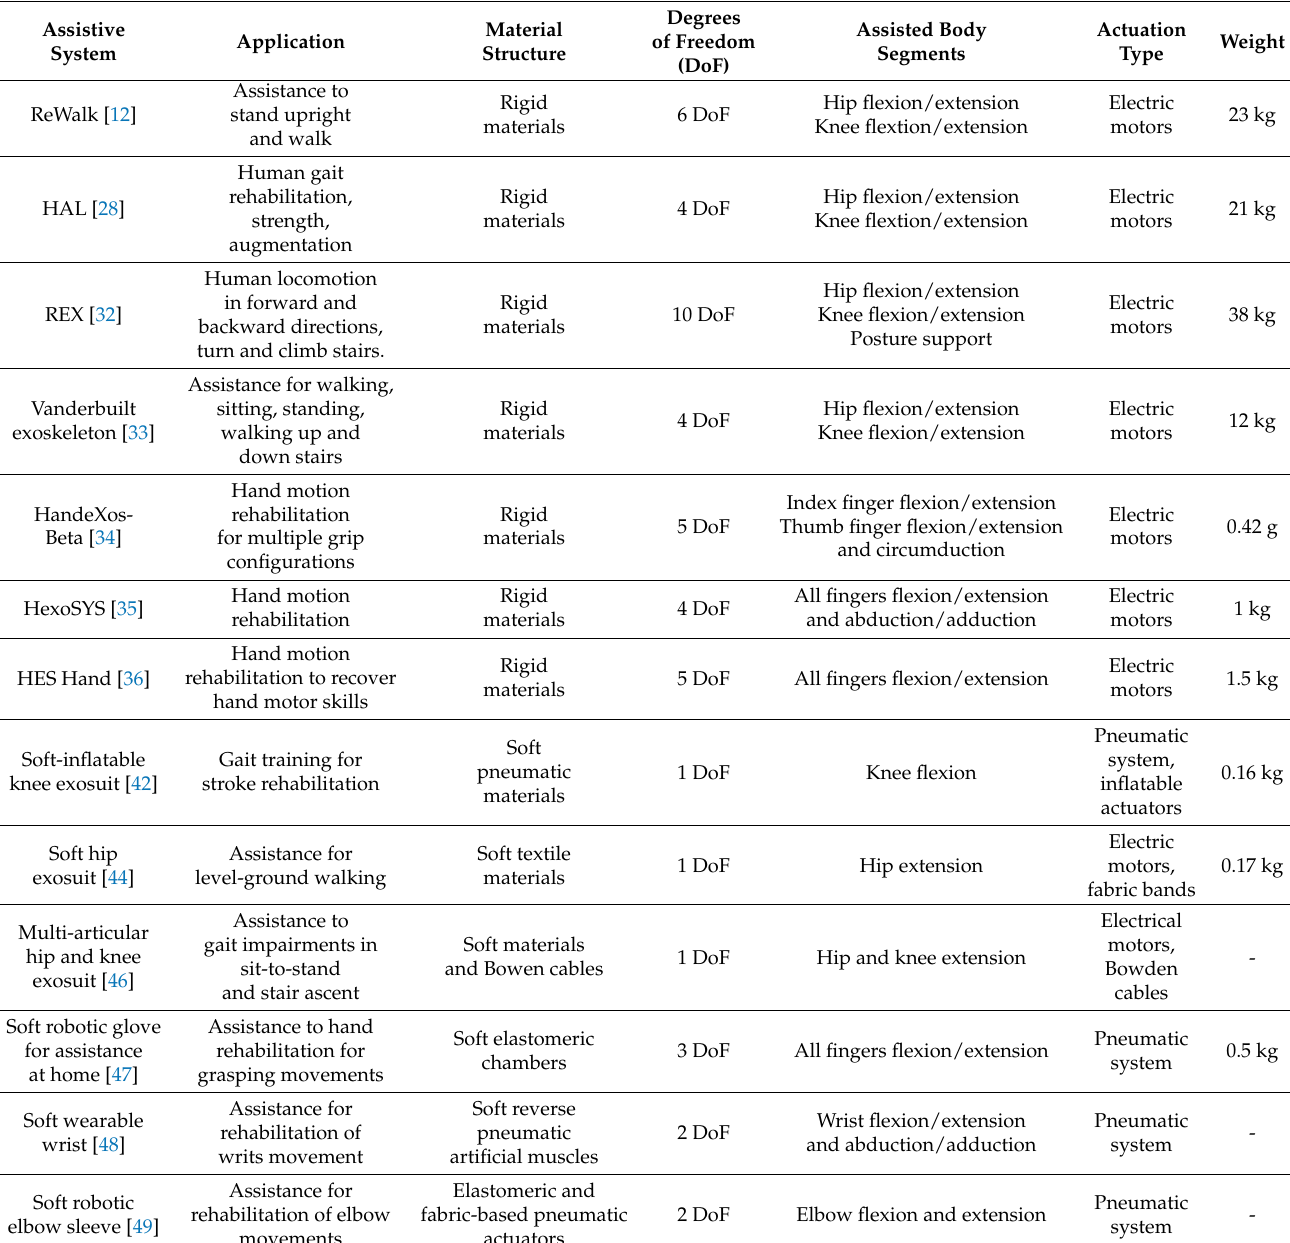
Table 1. Wearable robot technology for assistance to lower and upper